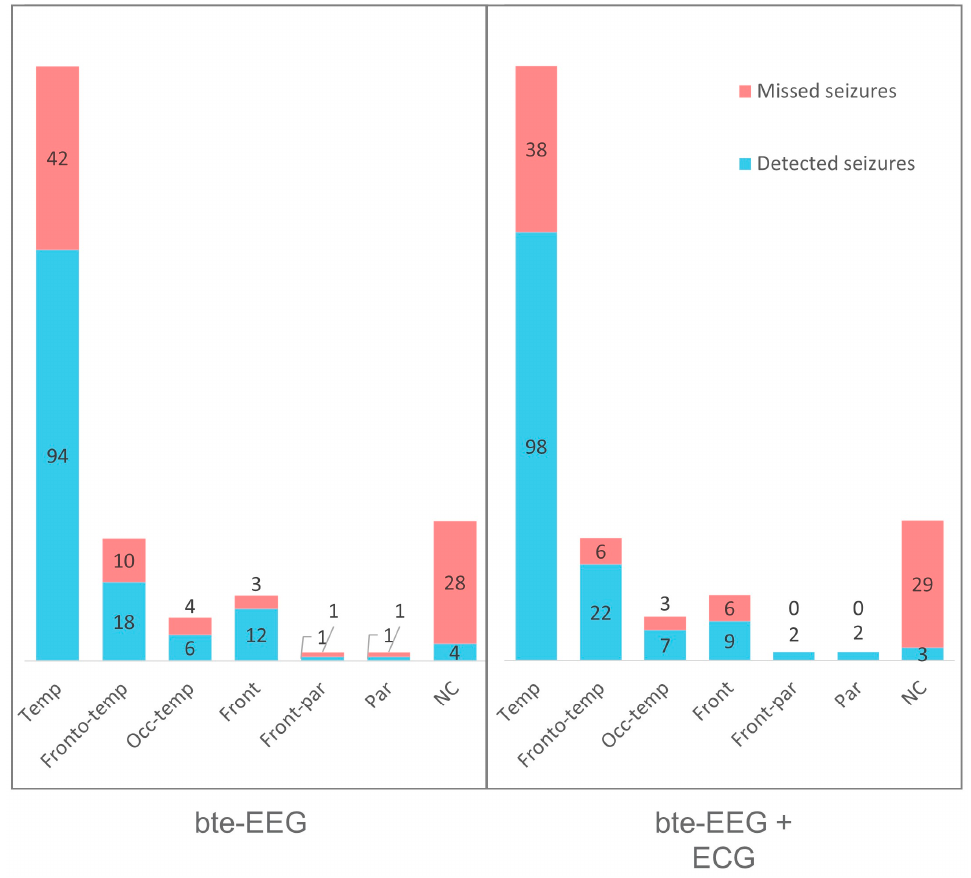
Figure 4. Number of detected (correctly annotated) and missed (mislabeled) seizures of the two readers in the two experimental setups readers, discriminated by the location of the seizure onset (Temp—Temporal, Fronto-temp—Fronto-temporal, Occ-temp—Occipital-temporal, Front—Frontal, Fronto-par—Fronto-parietal, Par—Parietal, or NC—Not Clear).